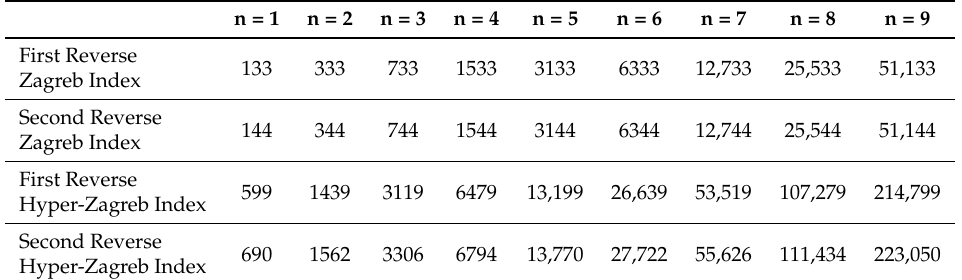
Table 4. Topological indices of Poly (EThylene Amide Amine)